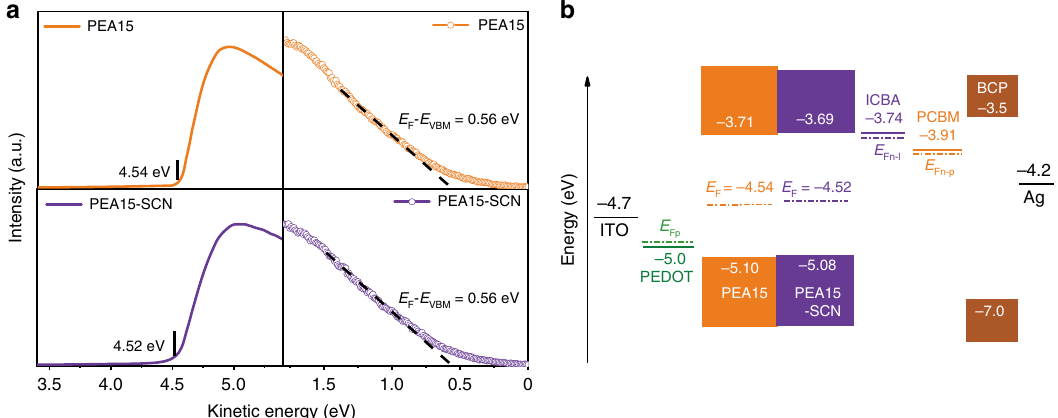
Fig. 2 Band structure of tin PSCs. a UPS spectra of secondary electron cutoff and valence band of perovskite fi lms. b Schematic illustration of energy levels. Dashed lines represent the quasi-Fermi level of ICBA ( E Fn – I ), PCBM ( E Fn – P ), and PEDOT ( E Fp